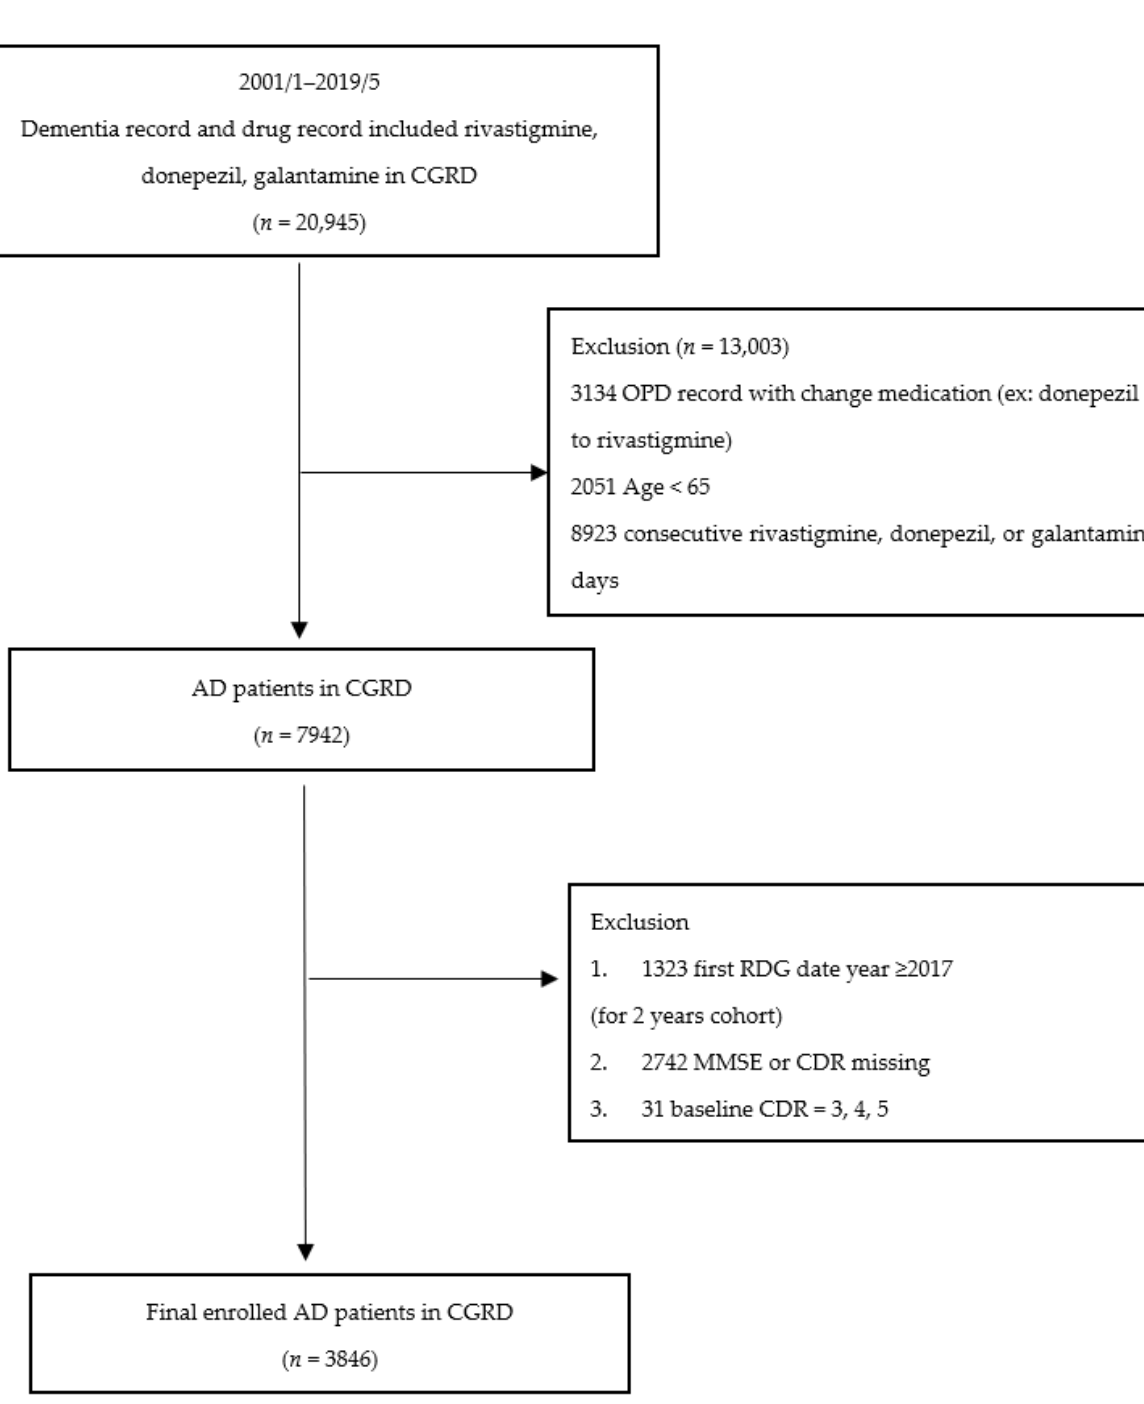
Figure 1. Flowchart of selection of study subjects.